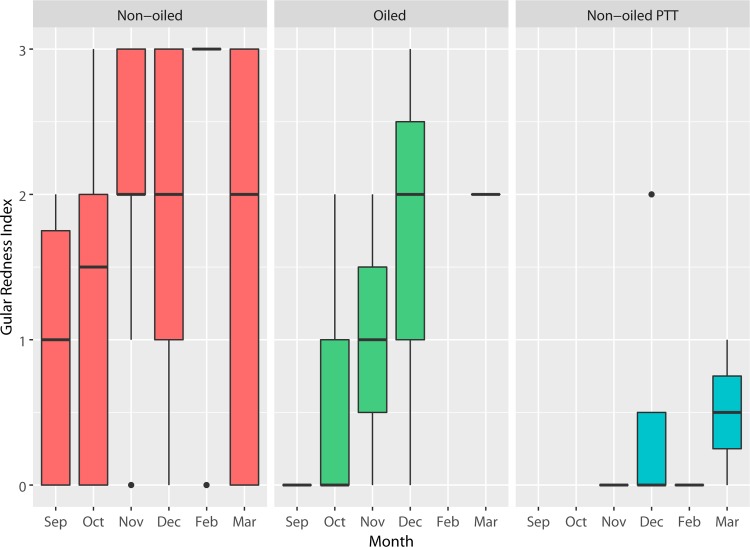
Gular redness scores for non-oiled, previously oiled, and non-oiled GPS-PTT bearing pelicans.Shown are medians, quartiles, and outliers across months. Sample sizes are as follows: non-oiled (N = 135), oiled (N = 17), non-oiled with GPS-PTT (N = 9). Data are from September 15, 2015-March 21, 2016.